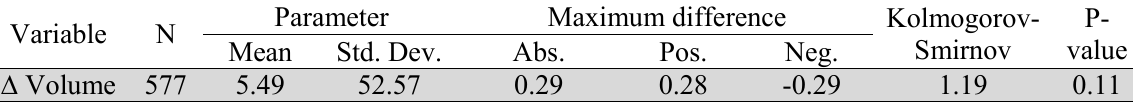
The summary of Kolmogorov-Smirnov test